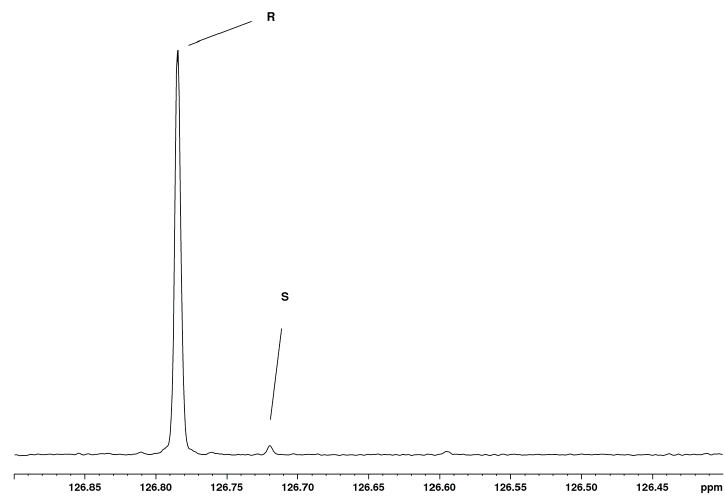
Figure 4. Expansion of 0.5 ppm of the 13 C NMR spectrum of the “pure” R enantiomer of